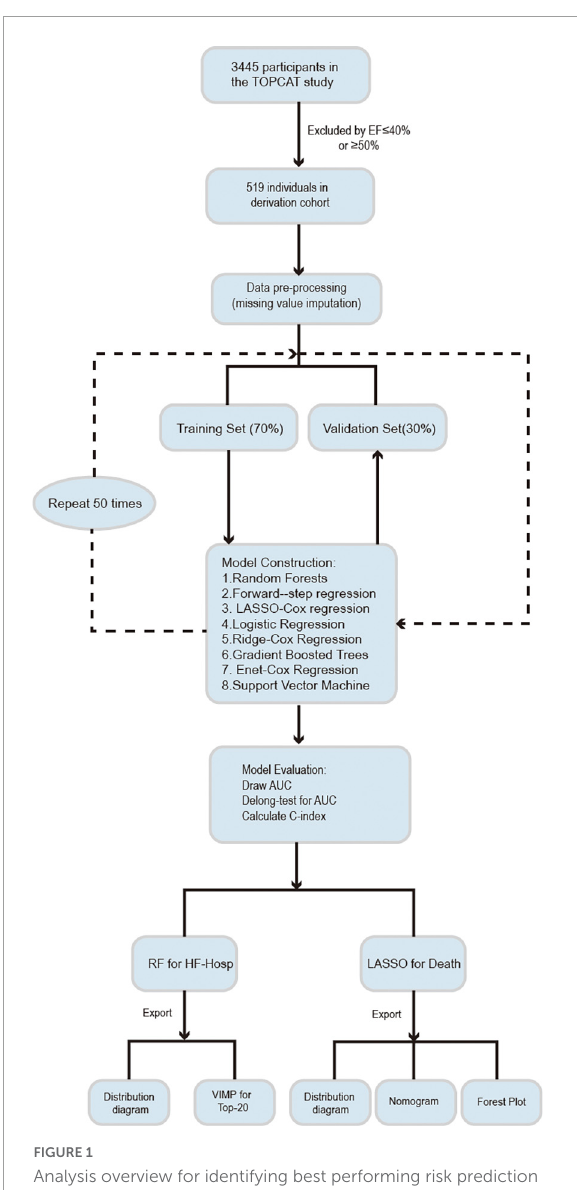
FIGURE1 Analysis overview for identifying best performing risk prediction